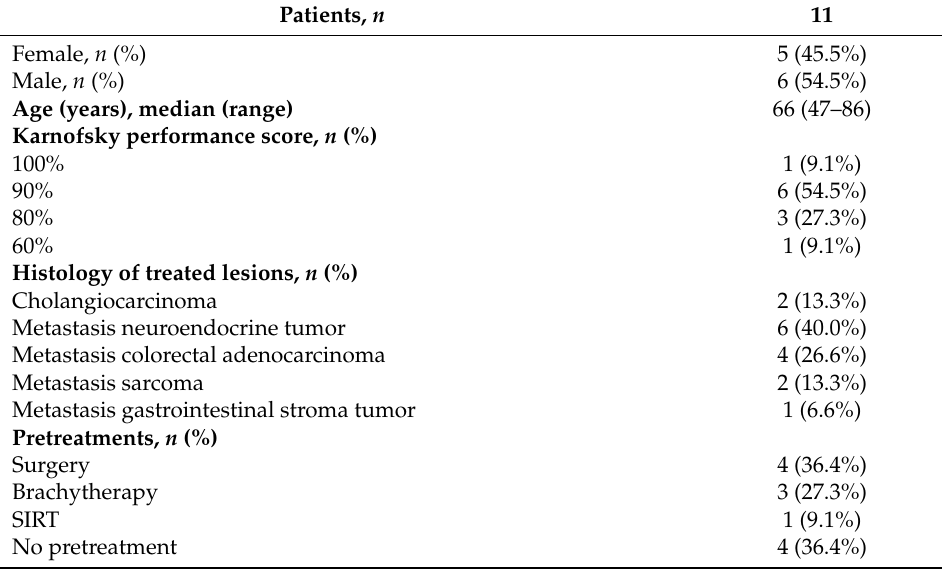
Table 1. Patient